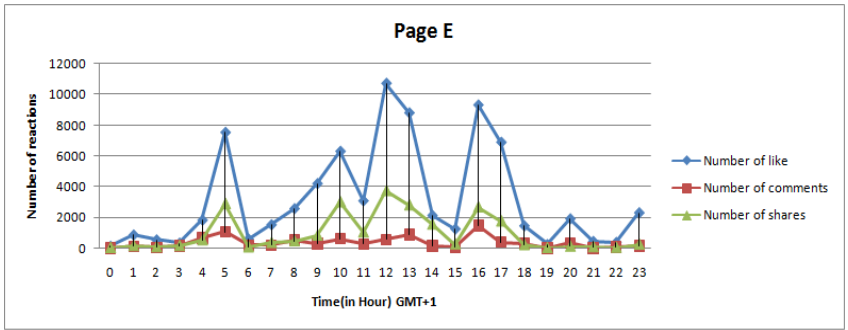
Fig. 6. Number of interactions per publishing hour for page E with 65